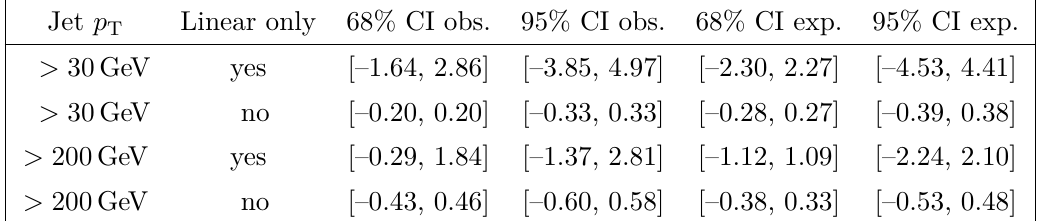
30 GeV or jet p 200 GeV. The new-physics scale T > T >